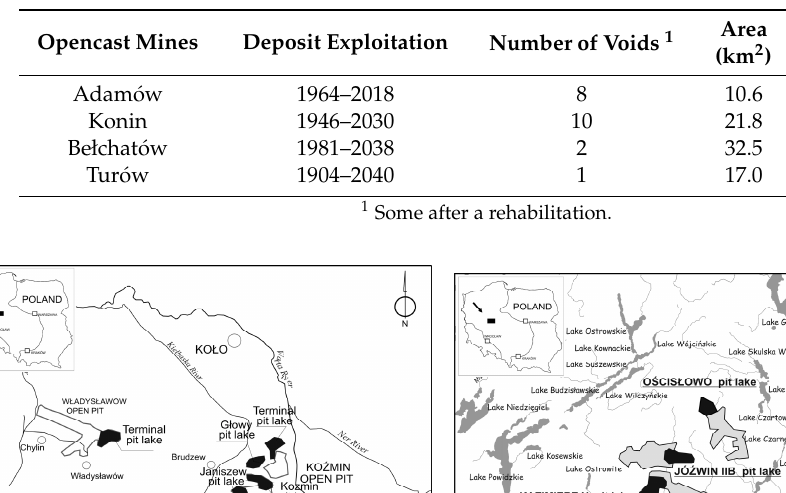
Figure 8. Hydrogeological cross-section through M ą koszyn Grochowiska deposit. Explanations: 1 — fine sands; 2 —glacial tills; 3 —silts; 4—clays; 5 —marls and dolomites; 6 —lignite; 7 —Neogene- Paleogene-Mesozoic aquifer piezometric surface ; 8 —stratigraphic boundary; 9 —screened intervals; 10 —fault [59].